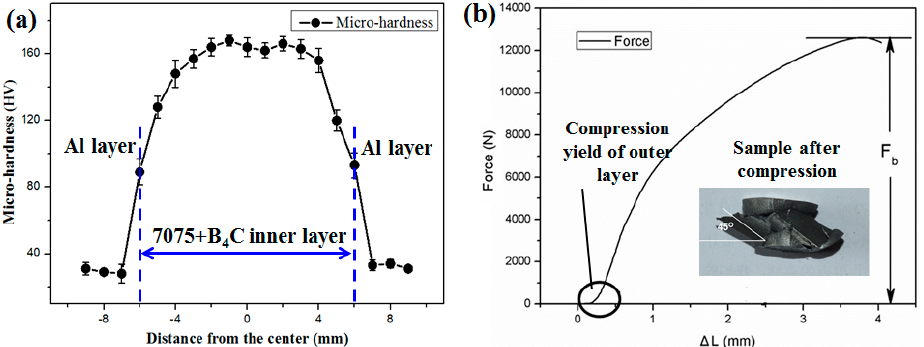
Figure 6. ( a ) Hardness test and ( b ) compression results of the BRALC.